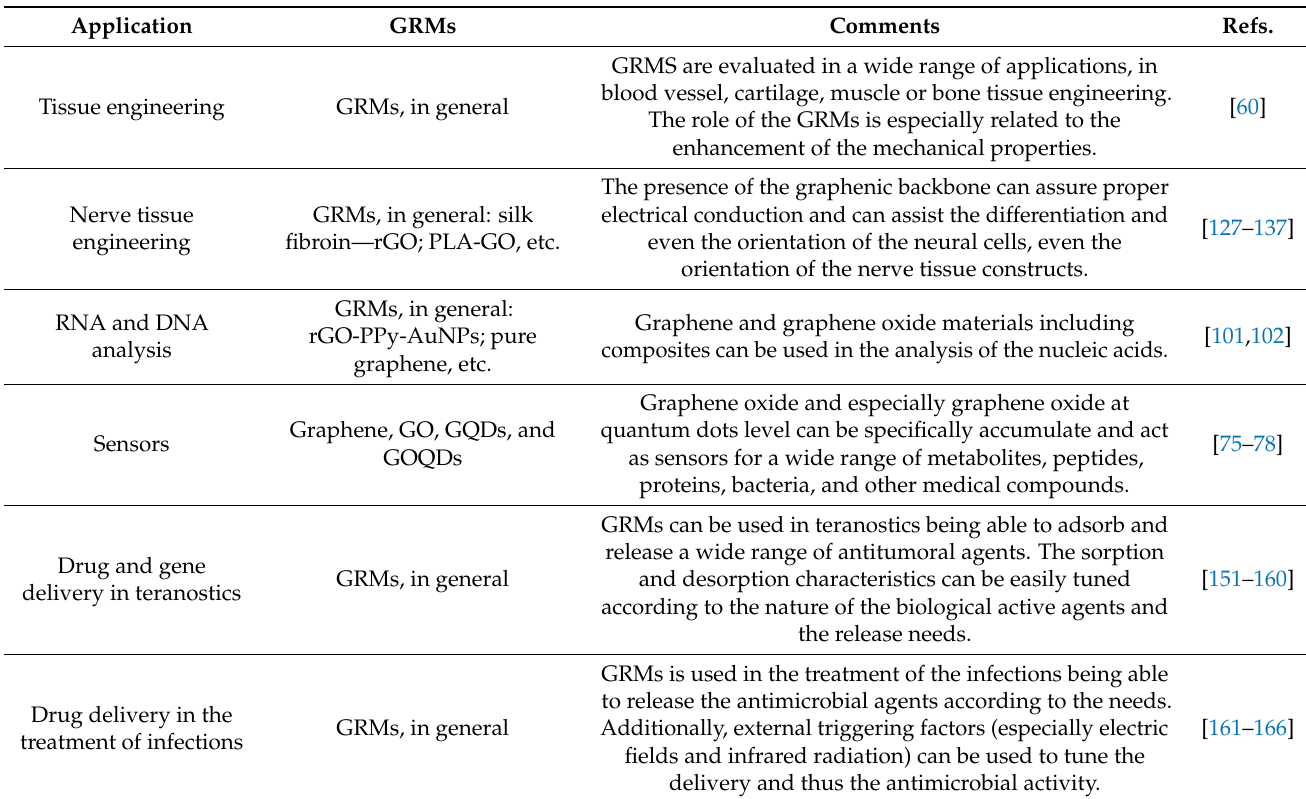
Figure 4. Preparation of the hybrid antibacterial system. Adapted from ref. [166]. Some of the most important applications of the GRMs are presented in Table 1. Table 1. Most relevant applications of GRMs in medical